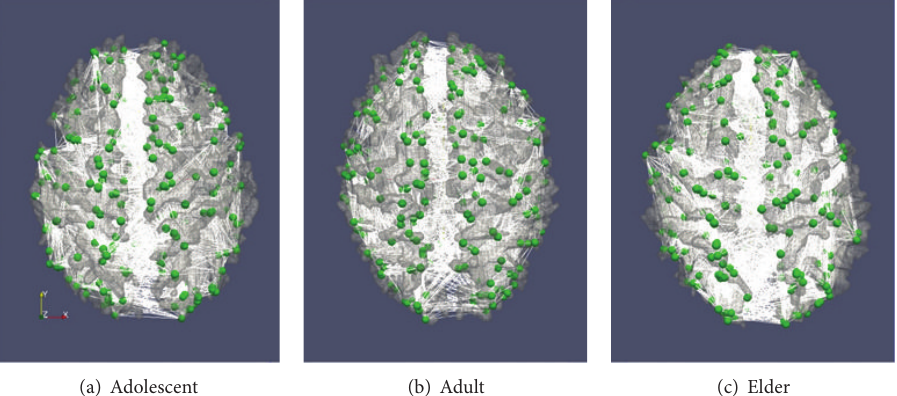
Figure 1: Examples of structural brain networks in different groups. (a) Adolescent group. (b) Adult group. (c) Elder group. The nodes are represented by green spheres and the edges are represented by white lines. The constructed structural brain networks are overlaid on the corresponding cortical surfaces reconstructed from DTI